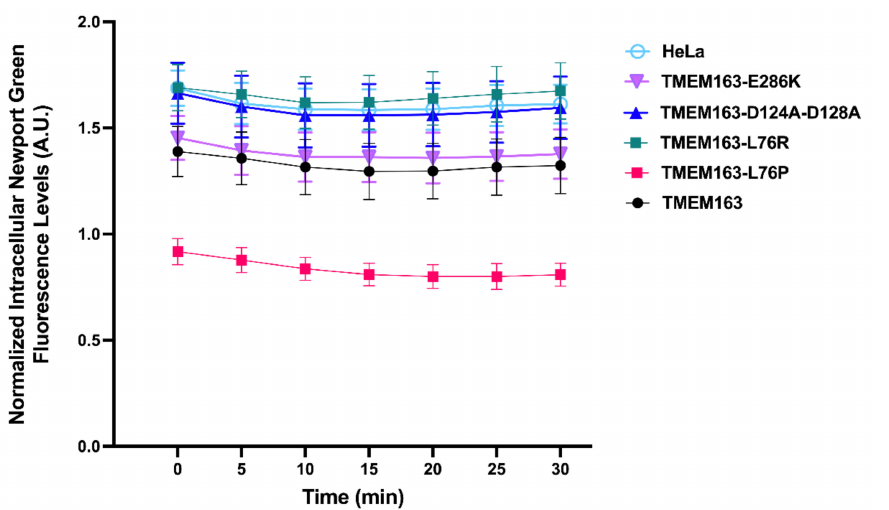
Figure 2. Intracellular zinc flux assay of HeLa cells stably expressing wild-type and variant TMEM163 proteins. The HLD-linked variant TMEM163 -L76P showed significantly enhanced zinc efflux, while the TMEM163 -L76R variant displayed marked loss of zinc efflux activity that mimicked the inactive TMEM163 -D124A-D128A mutant. Unmodified HeLa cells and stable cells expressing the TMEM163 - E286K mutant were included as additional controls. Significance testing was performed using ANOVA with repeated measures followed by a post-hoc analysis using Tukey’s multiple comparisons test ( p < 0.0001, n = 4 independent trials). Data are represented as means ± SEM. A.U., arbitrary